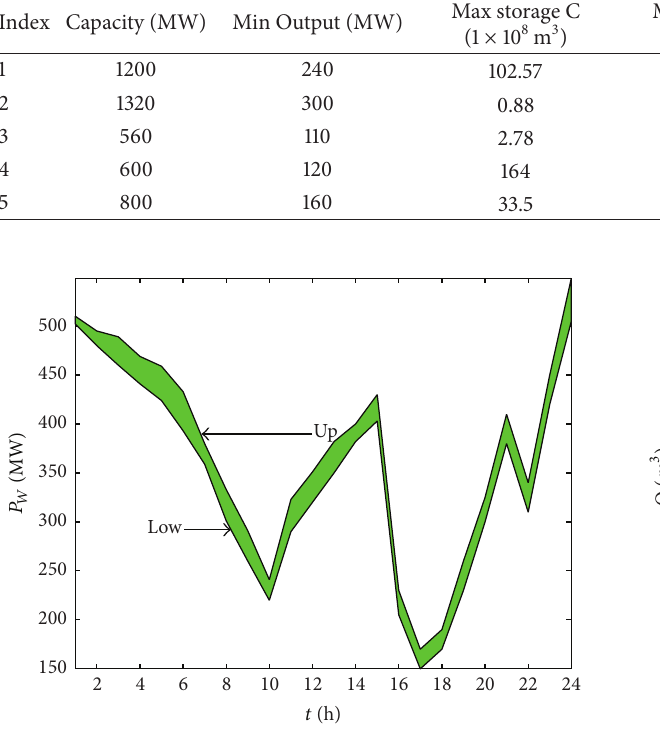
Figure 2: Prediction of the wind power output range.